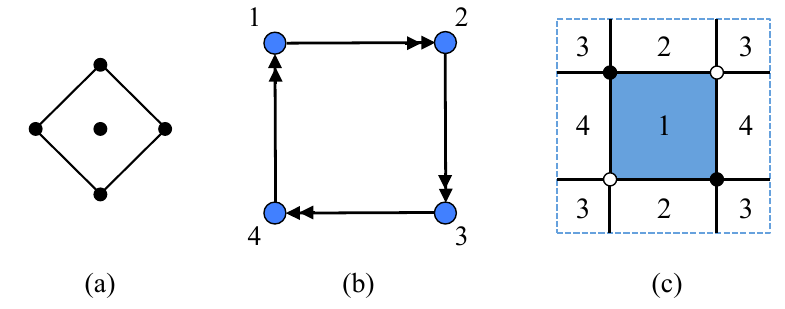
Figure 12. a) Toric diagram for F 0 . b) Quiver and c) dimer for its phase